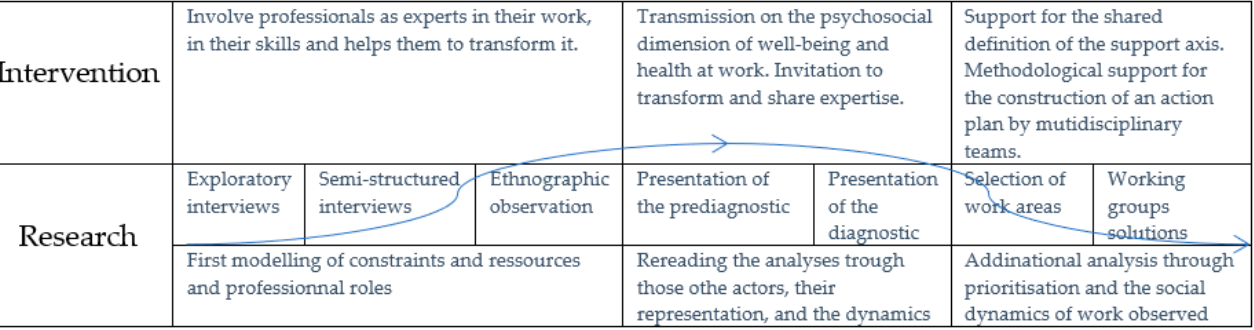
Figure 2. Dialectic of knowledge production between intervention and research.